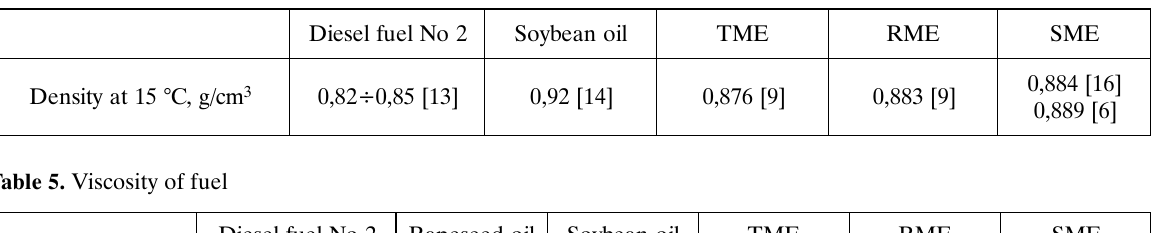
Table 4. Density of fuel